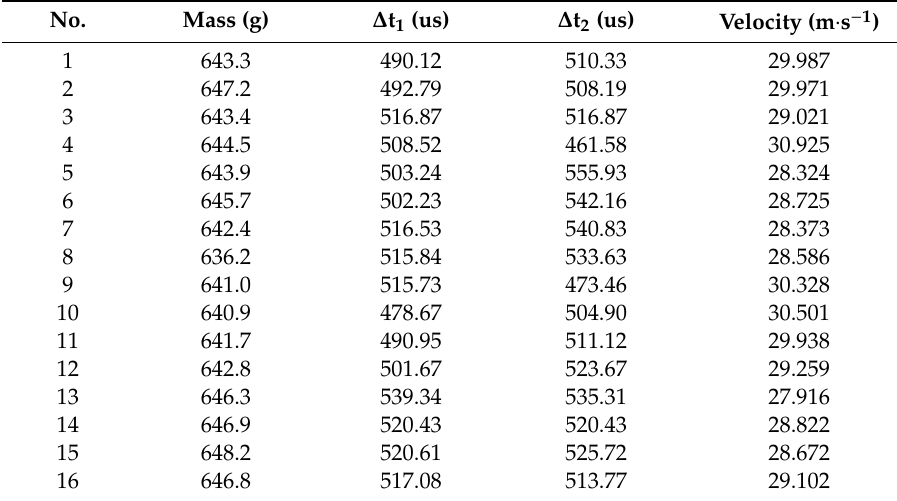
Table 7. Compression lengths of the aluminum honeycomb.